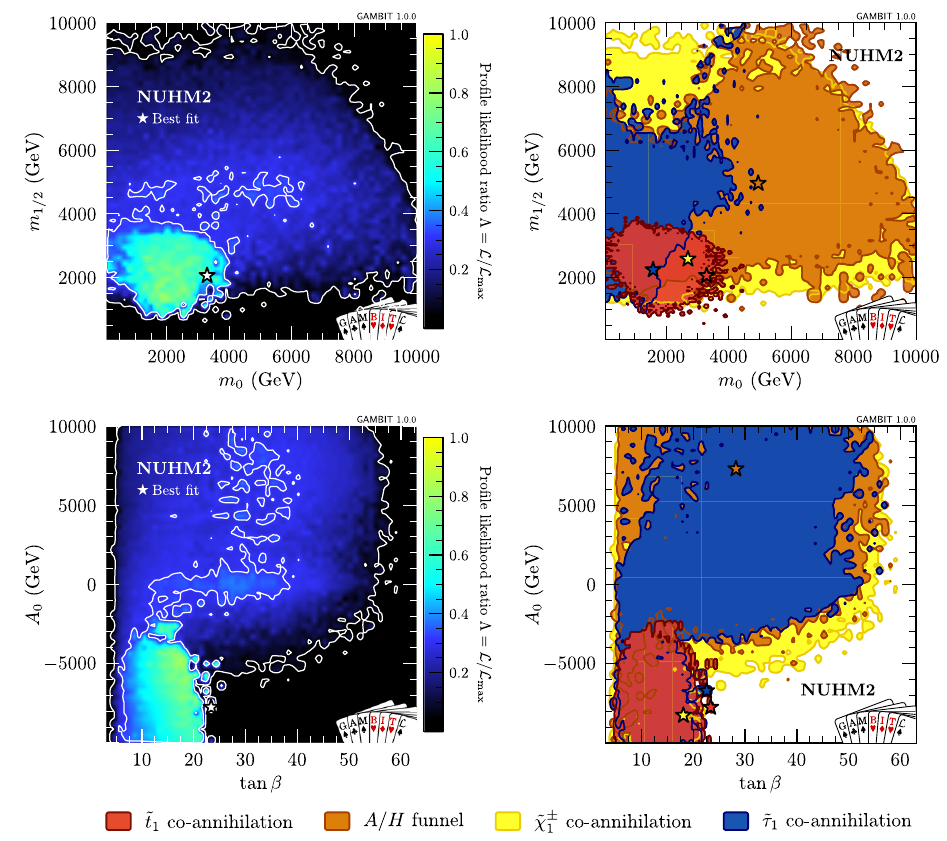
Fig. 8 Left: Profile likelihoods in the NUHM2, in terms of the m 0 − m 1 / 2 and A 0 − tan β planes. Right: corresponding mechanisms to avoid exceeding the observed relic density of DM